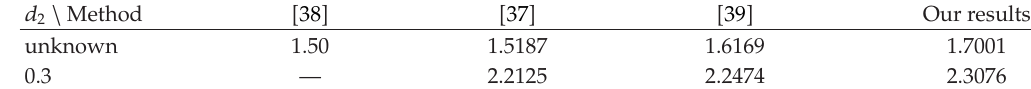
(cid:4) . 1 unknown